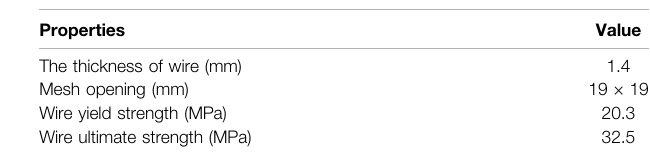
TABLE 5 | Wire mesh